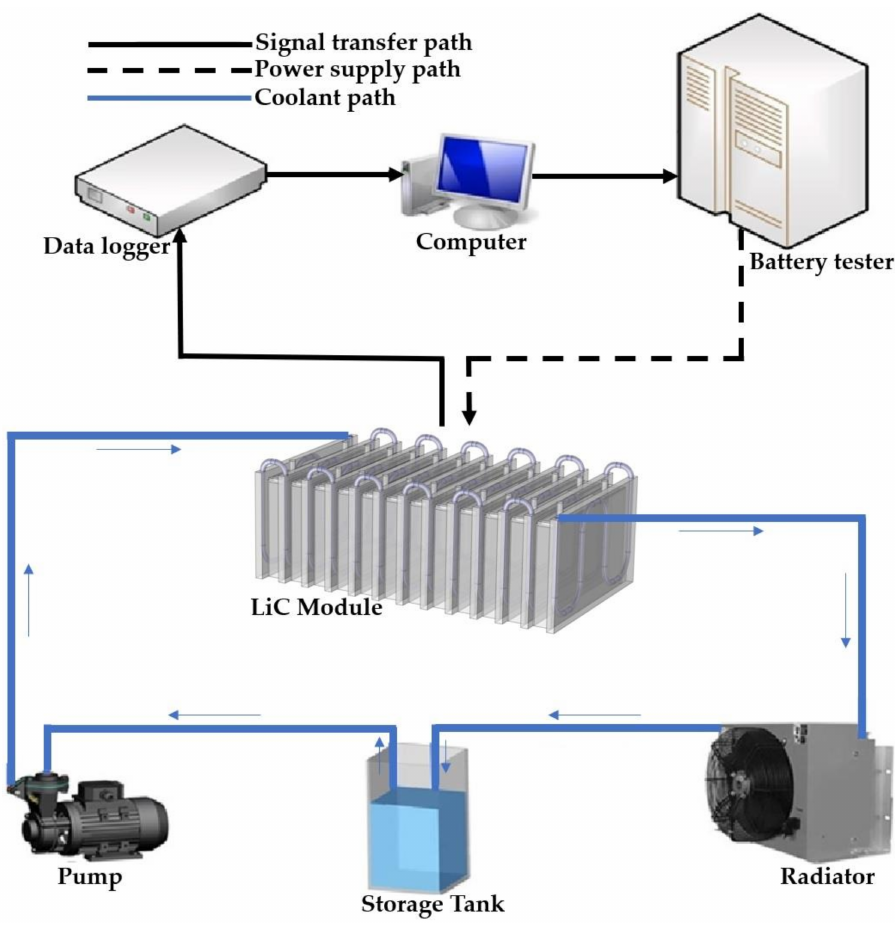
Figure 7. The schematic of the test bench for the proposed LCTMS.